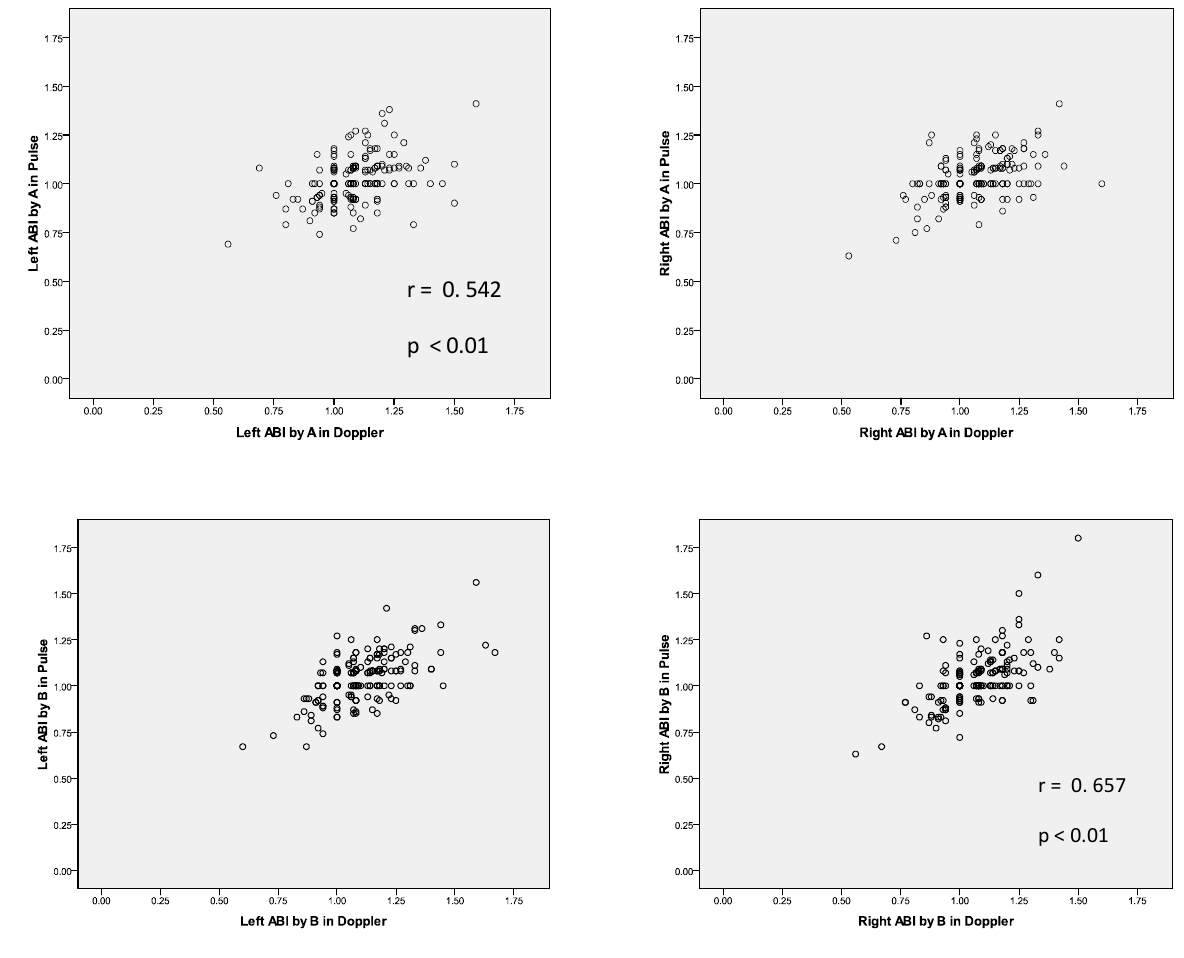
Figure 1. Scatter plots with regression showing the correlation between dABI and